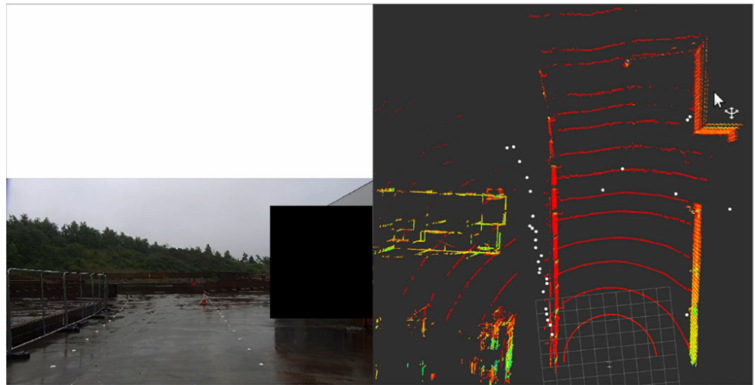
Figure 4. Visualization (before correction for several degrees of sensor misalignment) of false-positive detections in current exploratory research. The colored points in the point clouds visualization represent LiDAR point cloud data and white points represent radar point cloud data. Several false- positive radar detections are highlighted by the grey rectangle, located at approximately 5–7 m from the radar sensor. The radar sensor in present setup is in short-range mode (maximum detection range is 19 m); hence, the traffic cone located at 20 m is not